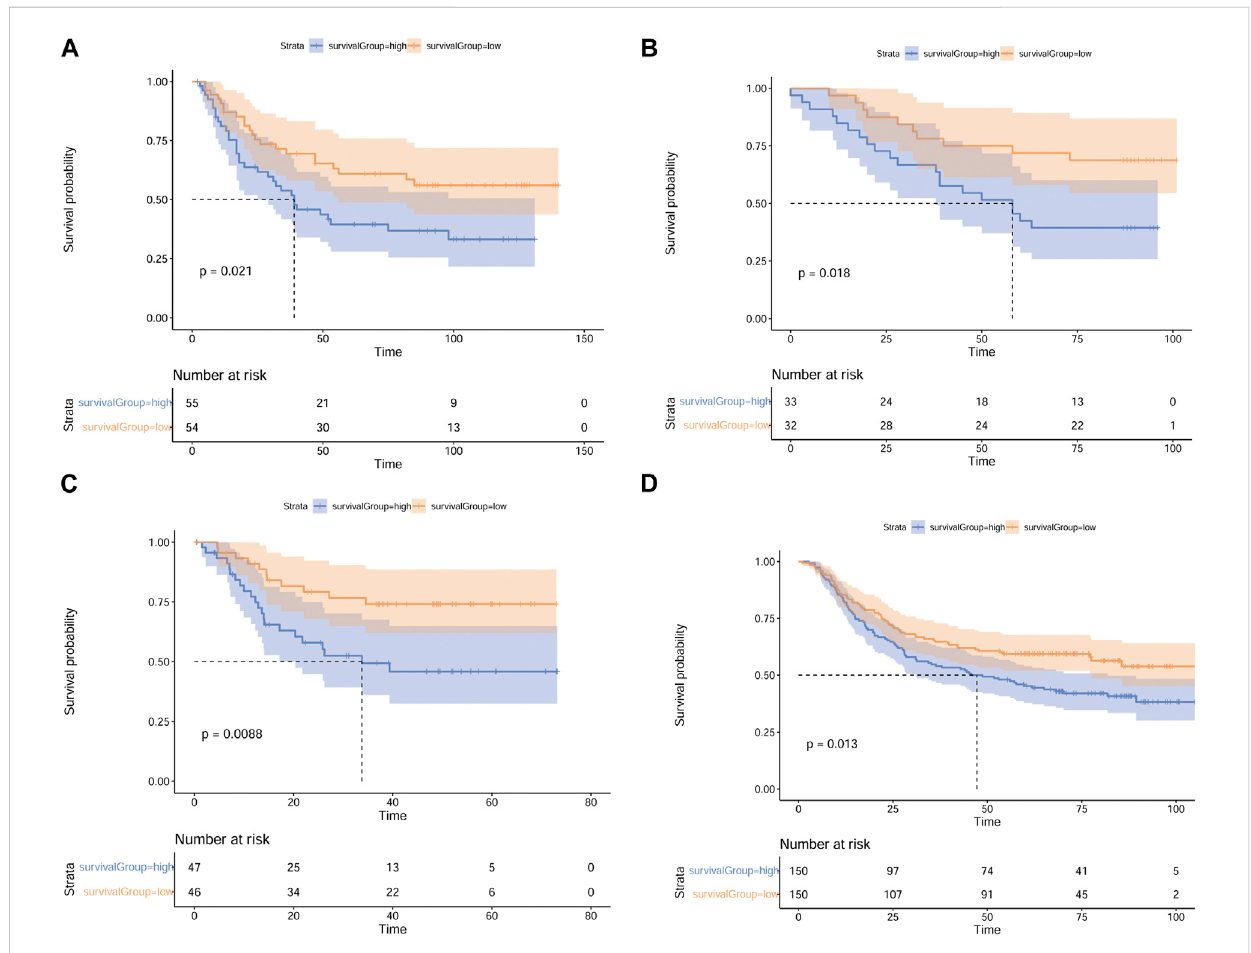
FIGURE 8 Validation of the MMP scoring system using 4 external datasets. Full validation of the MMP scoring system by four datasets GSE26901. (A) , GSE13861 (B) , GSE26899 (C) , and GSE66229 (D) in the GEO